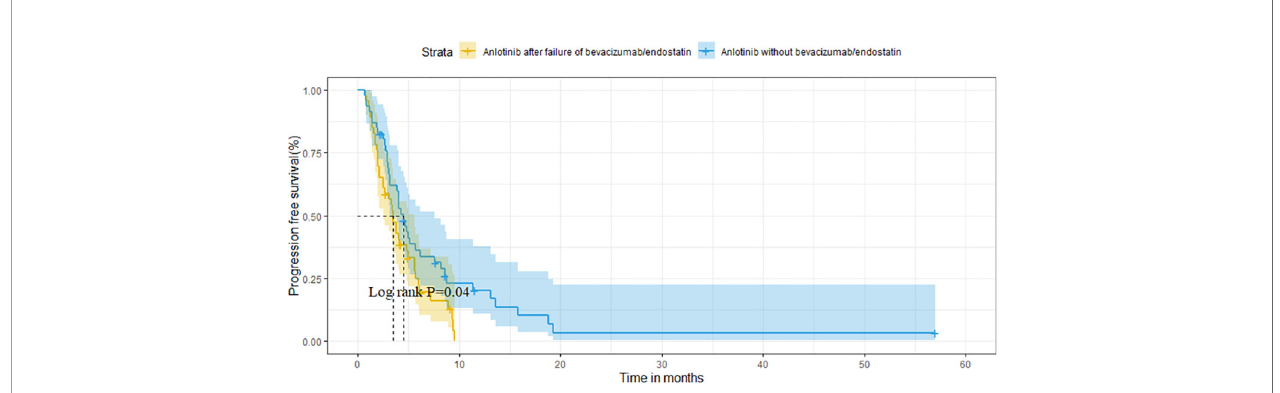
FIGURE 5 | Comparison of PFS between the two groups after matching.